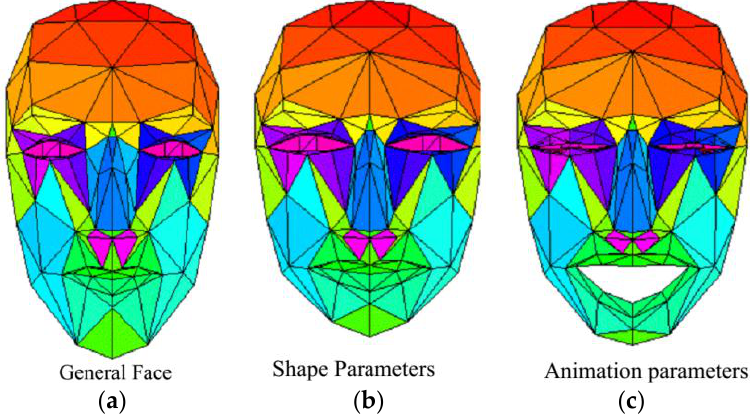
Figure 2. Candide-3 face model. ( a ) Is the general face; ( b ) is a face modified by shape parameters; ( c ) is a face modified by shape and animation parameters. ( c ) is a face modified by shape and animation